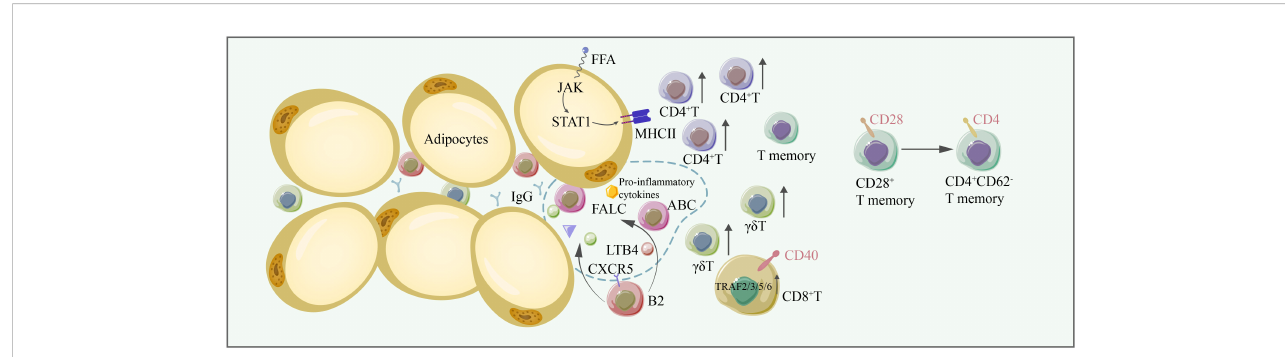
FIGURE 3 In aging adipose tissues, the number of conventional T cells, gd T cells, increases, thus contributing to adipose tissue in fl ammation. CD28+ T memory cells are converted to CD4+ CD62- memory T cells. FFA induces the expression of MHC-II through the JAK/STAT1 signaling pathway, facilitating antigen presentation to CD4+ T cells. CD40/TRAF2/3/5/6 signaling is critical for CD8+ T-cell-induced in fl ammation. B2 cells are recruited to FALC by LTB4, and CXCR5 on B2 cells is important for their recruitment to FALC. Some B2 cells become ABCs. B2 cells and ABC are proin fl ammatory, producing IgG